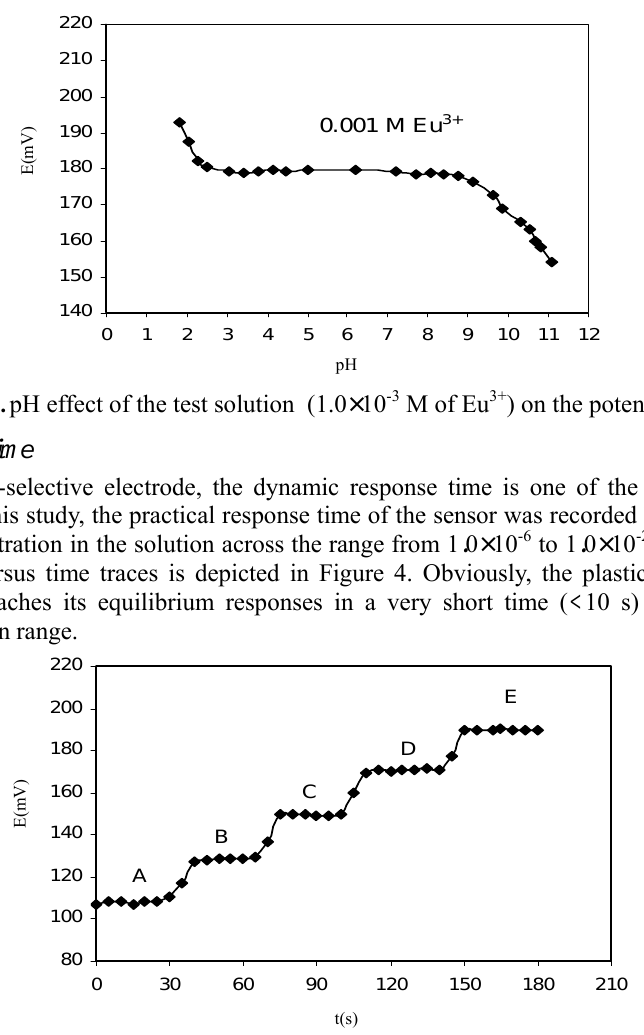
Figure 4. Dynamic response time of the europium electrode for step changes in the Eu 3+ concentration: A) 1.0 × 10 -6 M, B) 1.0 × 10 -5 M, C) 1.0 × 10 -4 M, D) 1.0 × 10 -3 M, E) 1.0 × 10 -2